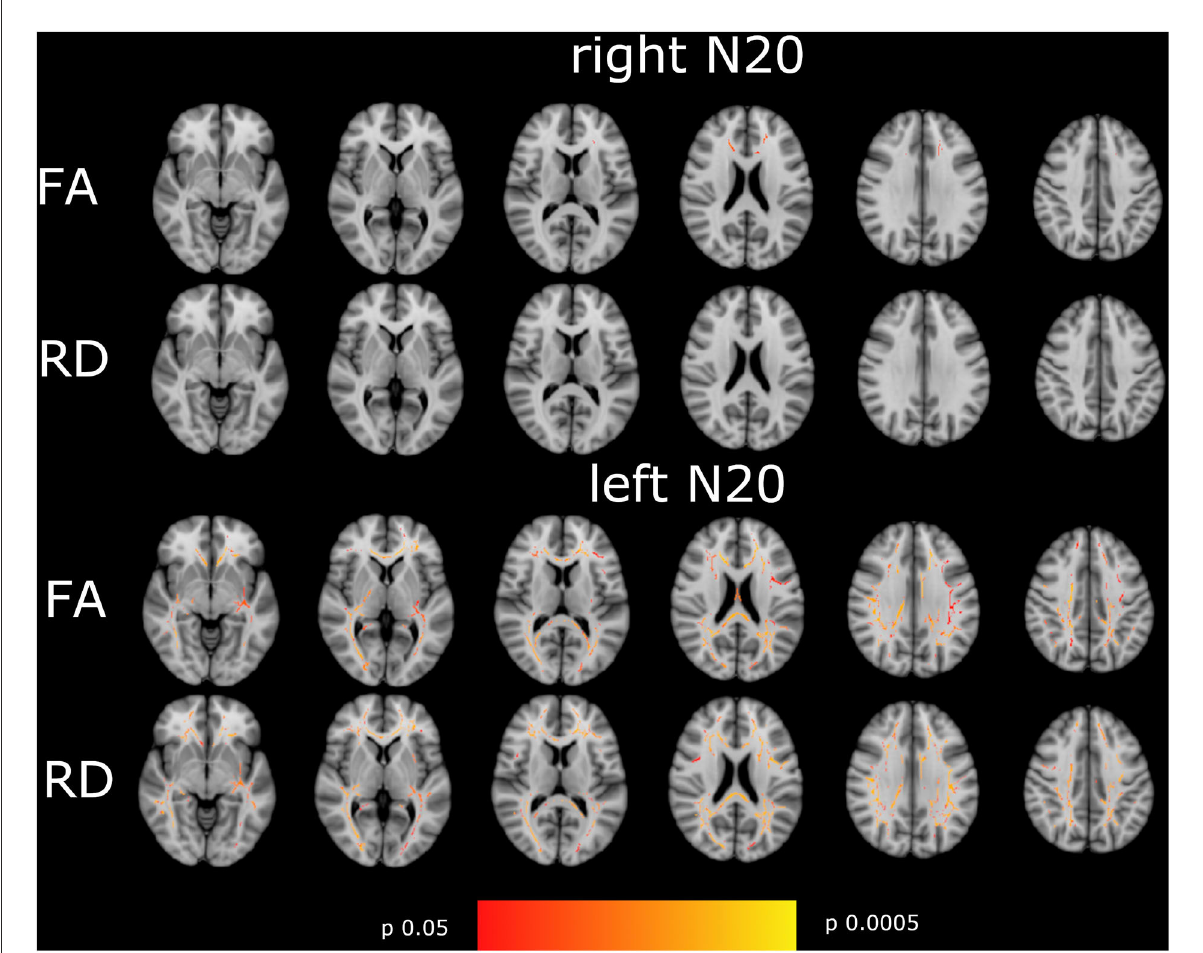
FIGURE3 Shown are the correlations of FA, and RD with right- and left-sided N20 of the tract-based spatial statistics results based on the GLM-model. Significant correlations are highlighted from red to yellow, from p = 0.0005 to p = 0.004. The T1 Montreal Neurological Institute 158 brain is the background image. First row: correlation of FA with right-sided N20. Second row: RD with right-sided N20. Third row: FA with left-sided N20. Fourth row: RD with left-sided N20. Correlations are widespread in the brain with the highest correlation in the corona radiata superior and posterior, the visual tract, and the corpus callosum in left-sided N20. Hardly correlations were found in right-sided N20 except for corpus callosum. To focus on side differences lesions are not shown.